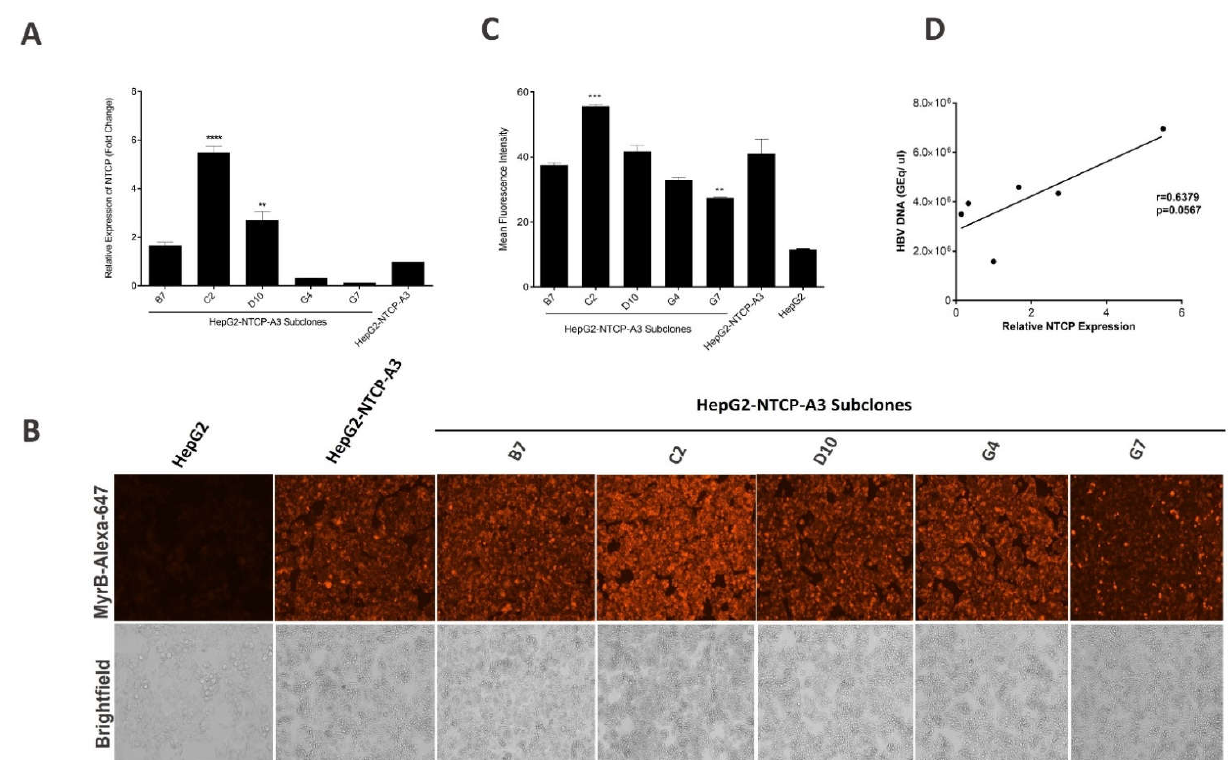
Figure 4. NTCP expression in subclones of HepG2-NTCP-A3 cells. ( A ) HepG2-NTCP-A3 parental clone stably expressing human NTCP were subcloned by limiting dilution into 96 well plates. Individual subclones were expanded and processed for NTCP mRNA quantification by reverse transcriptase real time PCR. HepG2-NTCP-A3 parental clone was set to 1 and represented as a fold change and the data are presented as mean ± SD (One way ANOVA; p < 0.0001; * level of significance); ( B ). HepG2, HepG2-NTCP-A3 parental clone and its subclones B7, C2, D10, G4 and G7 were stained for cell surface NTCP expression using Alexa Fluor labelled Myrcludex B (MyrB-Alexa-647) and visualized by fluorescence microscopy; ( C ). Quantitative representation of cell surface NTCP expression as mean fluorescence intensity (MFI); ( D ). Pearson correlation coefficient between NTCP expression levels and HBV infection in HepG2-NTCP-A3 parental clone and its subclones B7, C2, D10, G4 and G7.